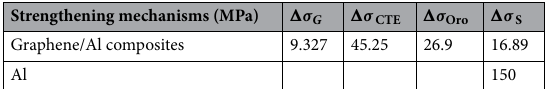
Table 1. The calculated results of Graphene/Al